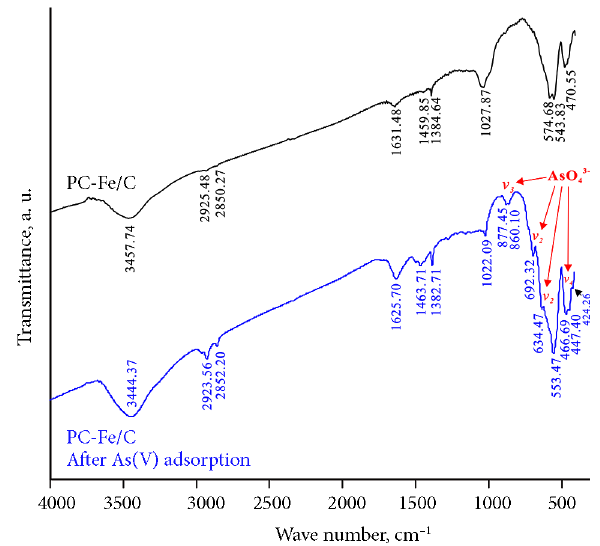
Figure 1. XRD patterns of the PC-Fe/C adsorbent prepared with eucalyptus wood biotemplate